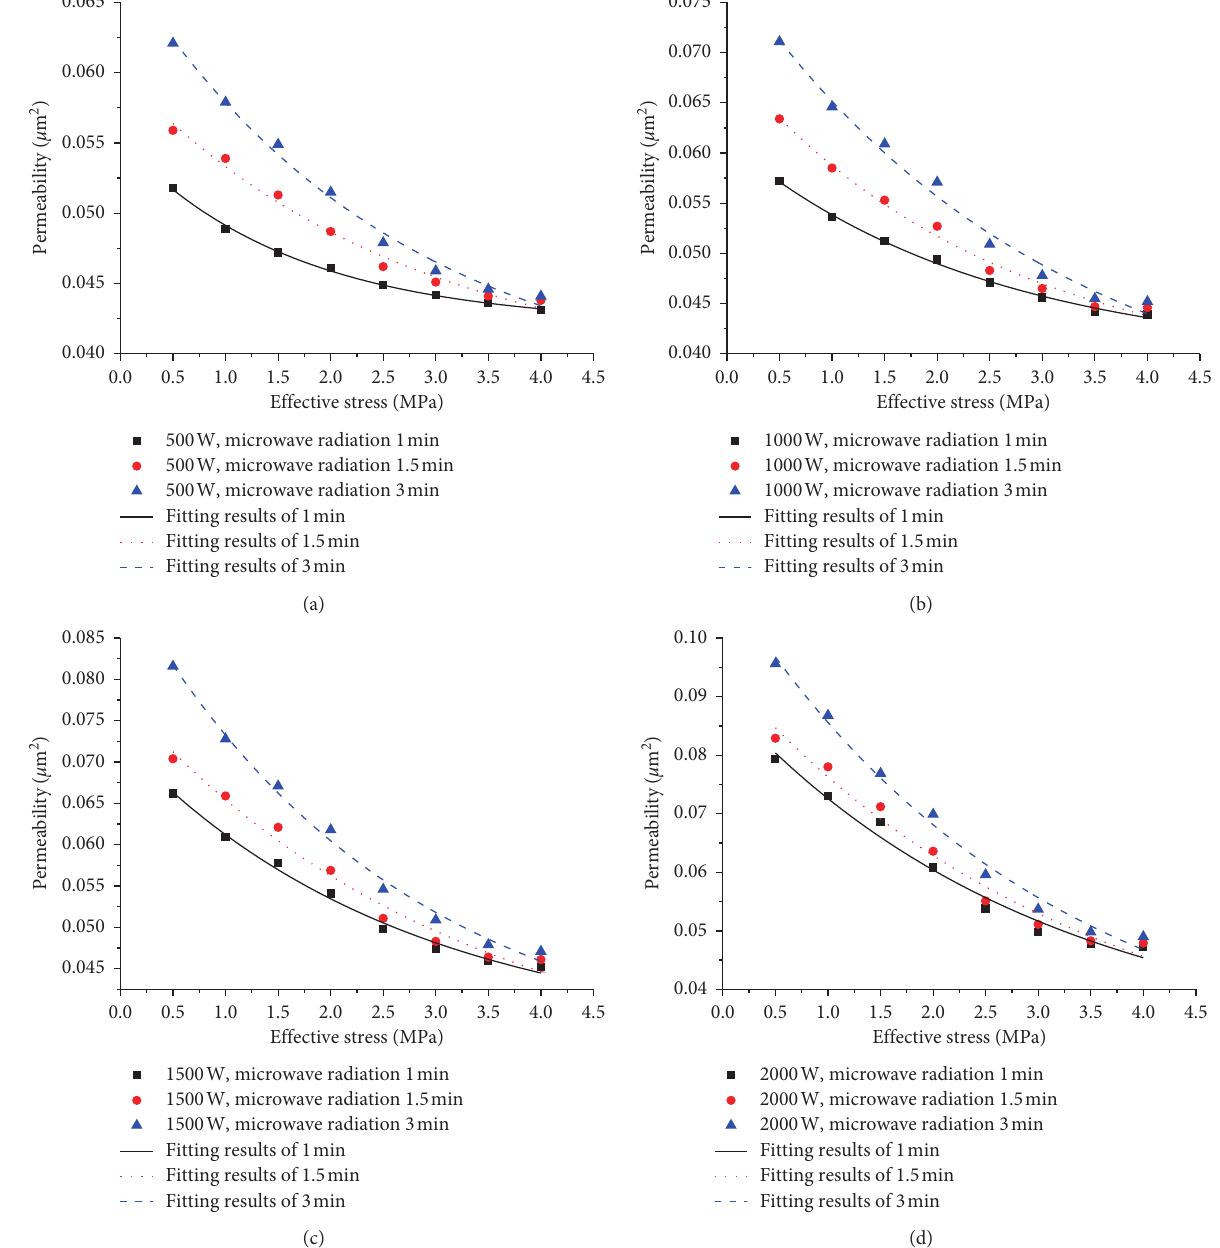
Figure 5: Changes in permeability with irradiation time at a confining pressure of